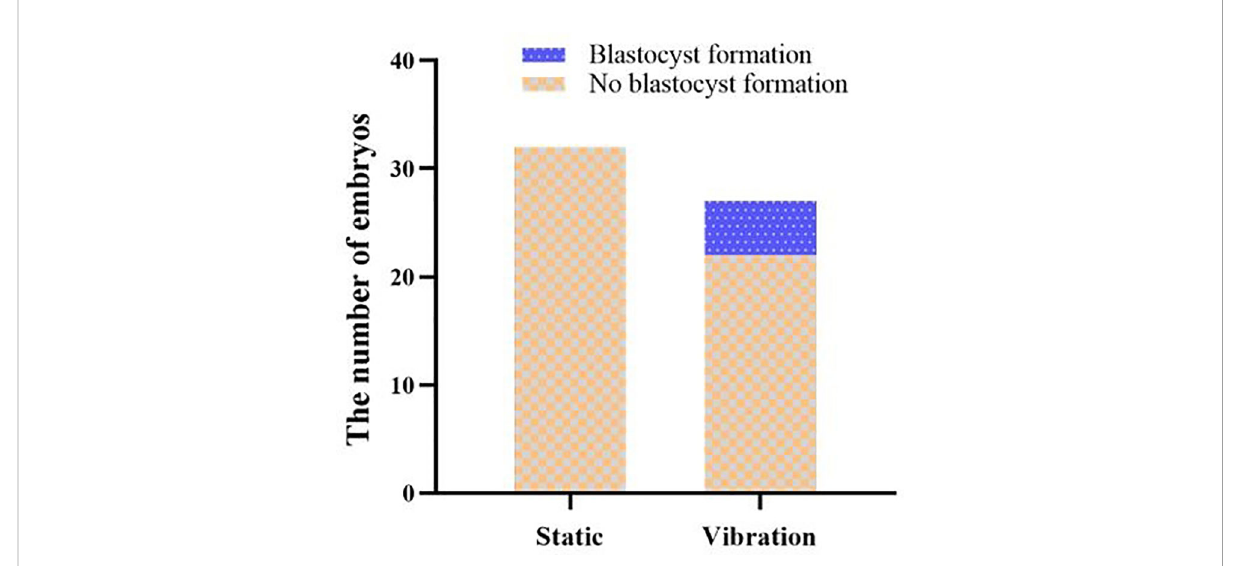
FIGURE 2 Effect of microvibration stimulation on the parthenogenetic development. The number of embryos forming (blue box) or not forming (orange box) blastocyst during